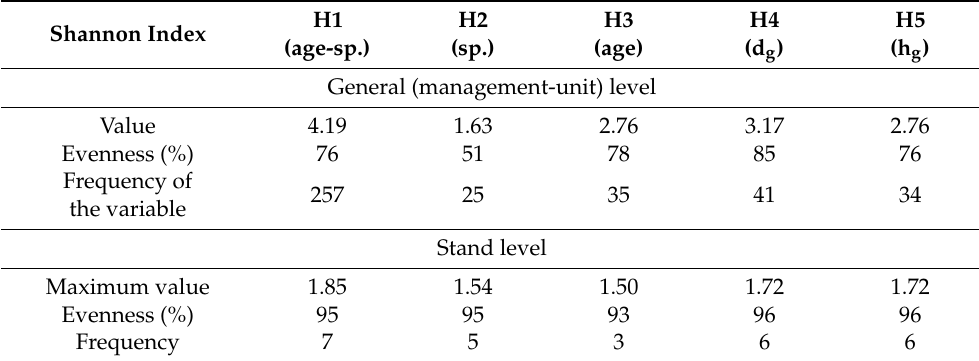
Table 3. Shannon index per management unit.